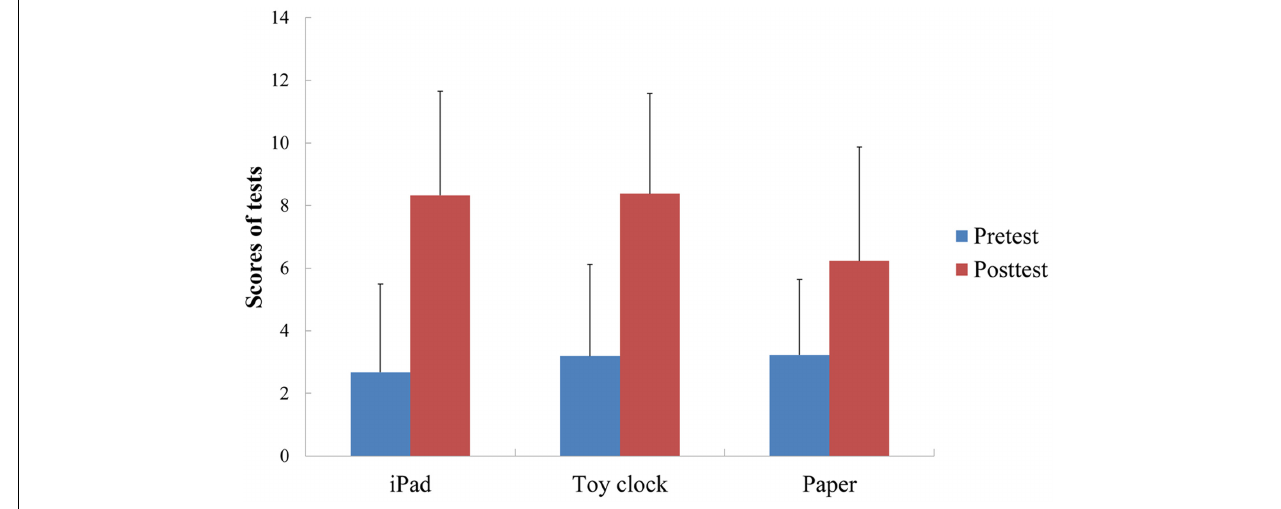
FIGURE 3 | Means of pre-test and post-test scores (with SD ) as a function of test